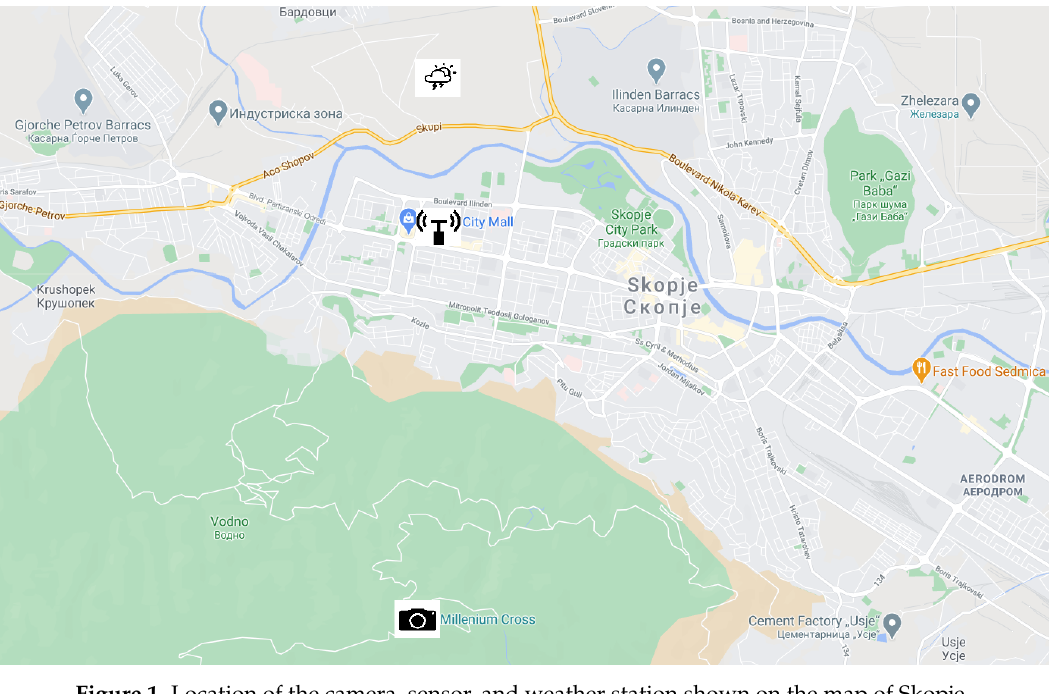
Figure 1. Location of the camera, sensor, and weather station shown on the map of Skopje.